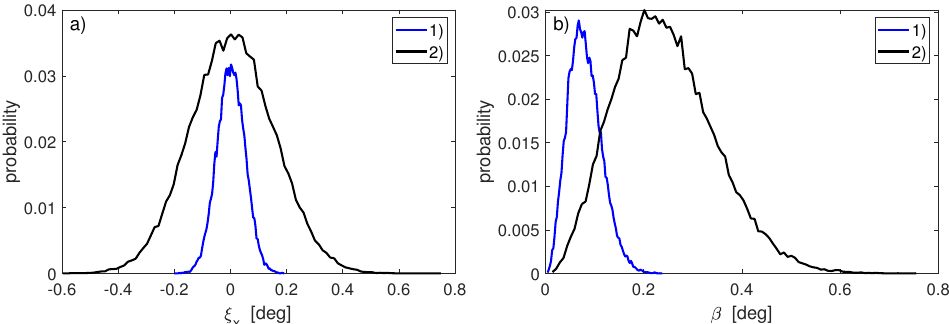
Figure 1. Characteristics of simulated small random rotations N k in (22): ( a ) histograms of x com- ponent of angle vectors ξ k ; ( b ) histograms of angle of rotation β of rotation matrix N k . Blue lines correspond to weak noise with σ a = 0.05 ◦ and black lines correspond to strong noise with σ a = 0.15 ◦